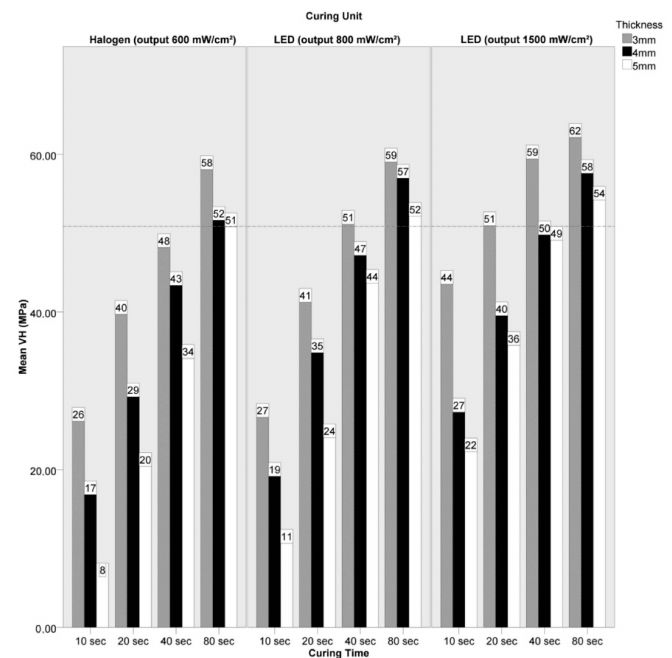
Figure 5. Bar chart summarizing mean Vickers Hardness (VH) numbers obtained in the AUR group using overlays with different thicknesses and after 10, 20, 40 or 80 s curing time. The horizontal line indicates 80% of the VH value achieved in the respective control group, which was used as the acceptability threshold for this